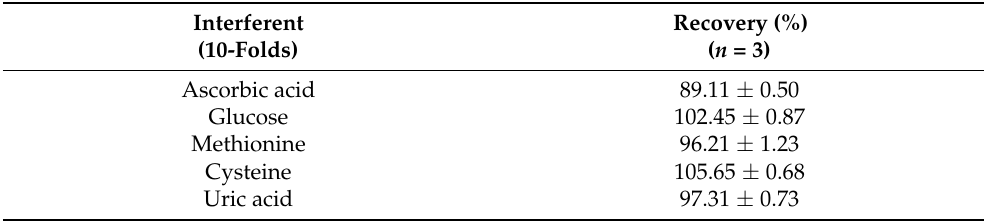
Table 3. The H 2 O 2 (200 µ M) recovery data for the proposed electrode in the presence of common interferents (10-fold concentration, 2 mM).